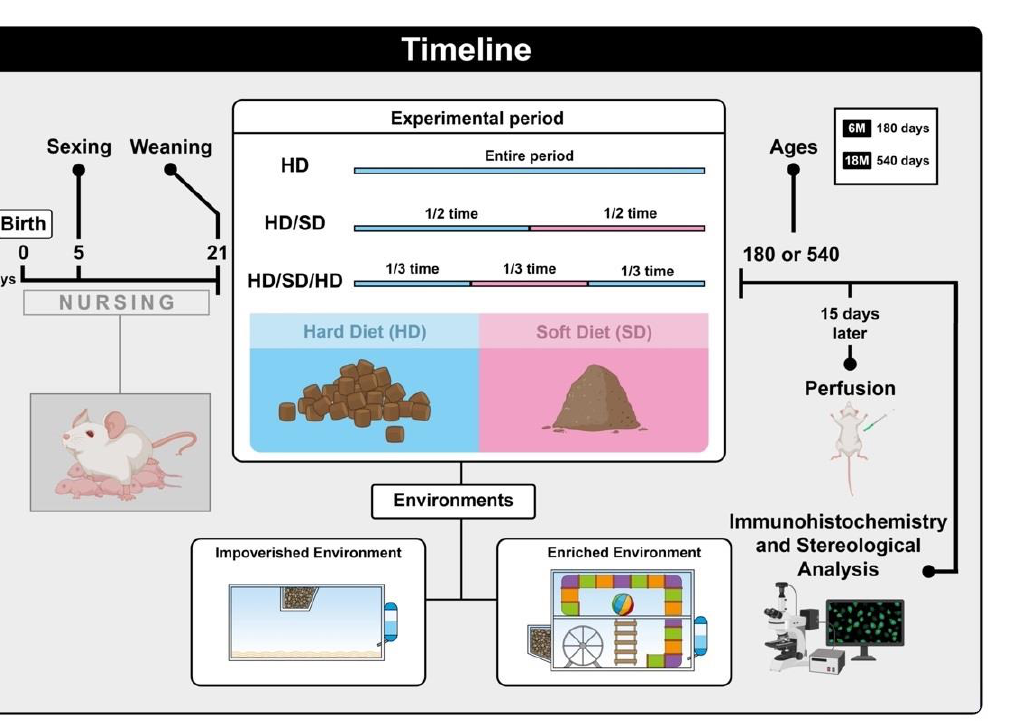
Figure 5. Experimental timeline. Female albino Swiss mice, Mus musculus , were selected on the 5th postnatal day and remained breastfeeding until the 21st postnatal day. After this period, the animals were divided into groups that were fed a continuous hard pelleted diet (HD), a hard diet followed by a soft diet (HD/SD group), or a hard diet followed by a soft diet and again a hard diet (HD/SD/HD). The total time of each feeding regimen was 6M (180 days) and 18M (540 days), representing respectively young and aged adult mice. The alternating diets (HD/SD and HD/SD/HD) were equally distributed over the lifespan (1/2 time and 1/3 time). Half of the animals were kept in poor environments in standard laboratory cages (impoverished environment (IE)) and the other half in environmentally enriched cages (enriched environment (EE)). After completing the experimental time